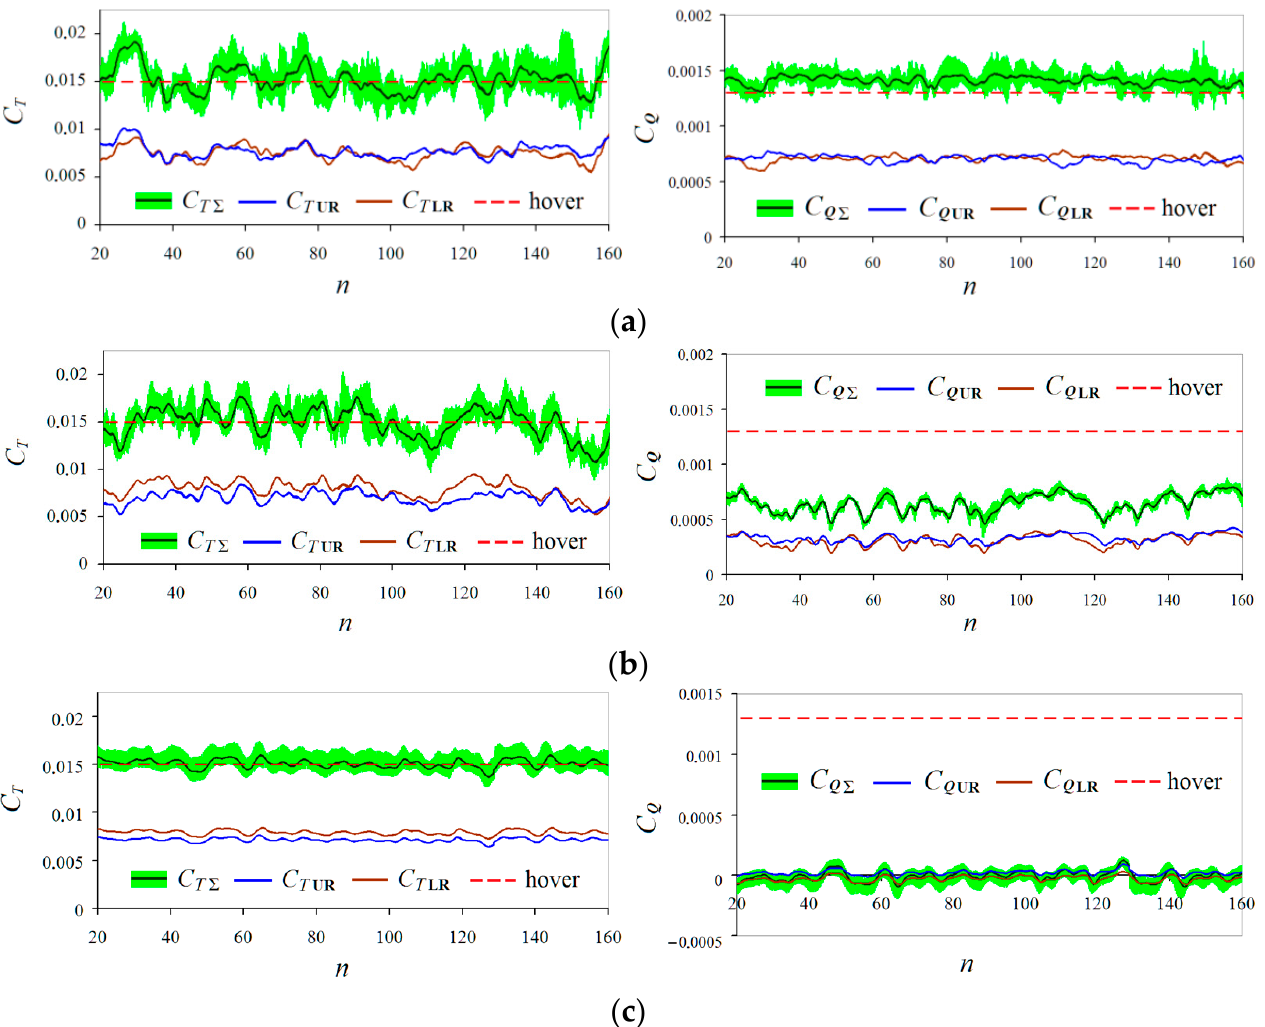
Figure 9. Diagrams of the dependence of the thrust C T = f(n) and torque C Q = f(n) coefficients vs. the number of revolutions of the rotor at α R = 50° for different vertical descent speeds: V y = 6 m/s ( a ); V y = 12 m/s ( b ); V y = 18 m/s ( c ).